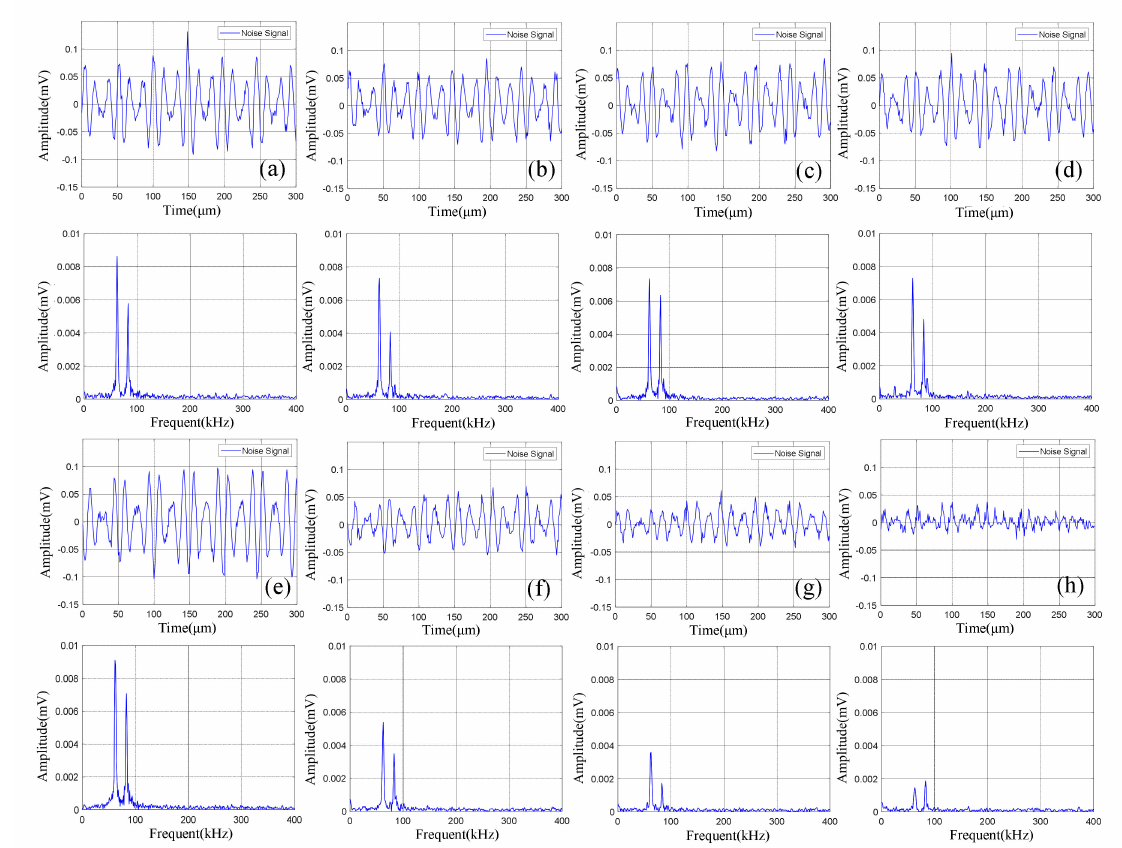
Figure 8. Time domain-frequency domain diagram of 0–600 cycles of discharge of Group A batteries: ( a ) 0 cycles; ( b ) 10 cycles; ( c ) 100 cycles; ( d ) 200 cycles; ( e ) 300 cycles; ( f ) 400 cycles; ( g ) 500 cycles; ( h ) 600 cycles.